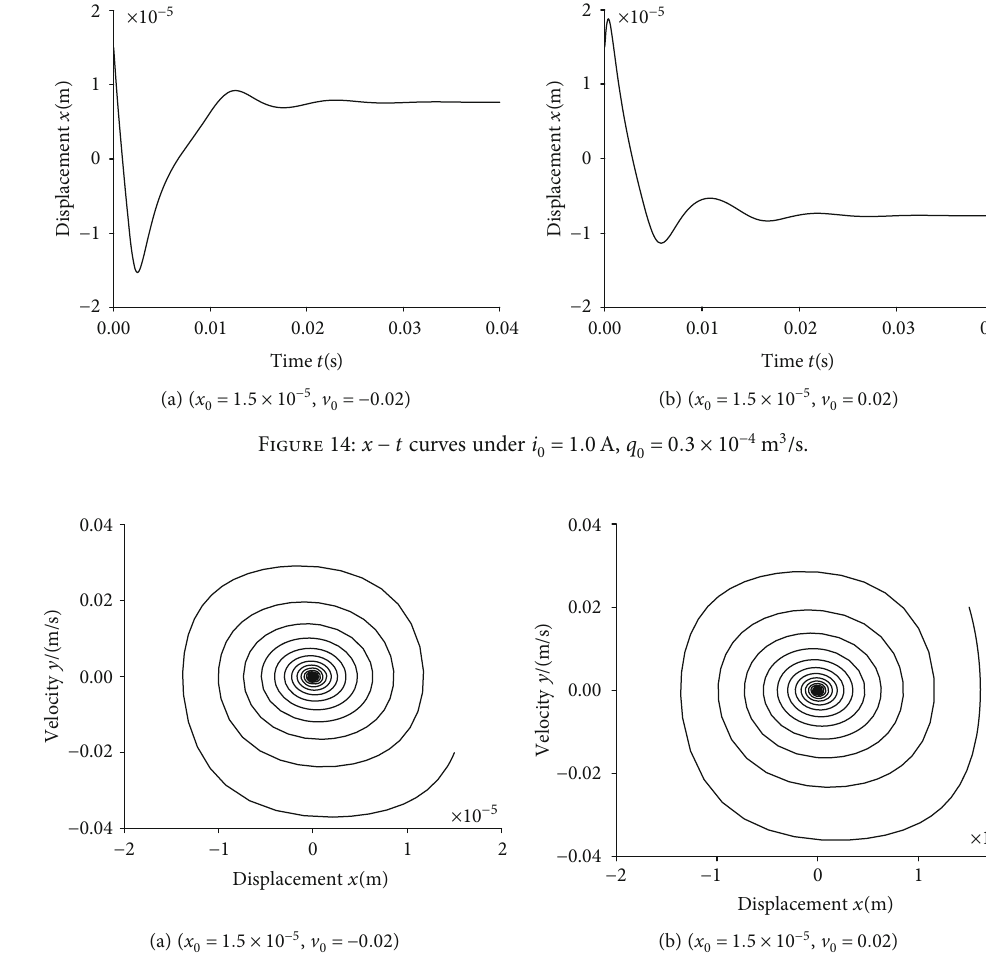
Figure 15: Phase trajectories under i